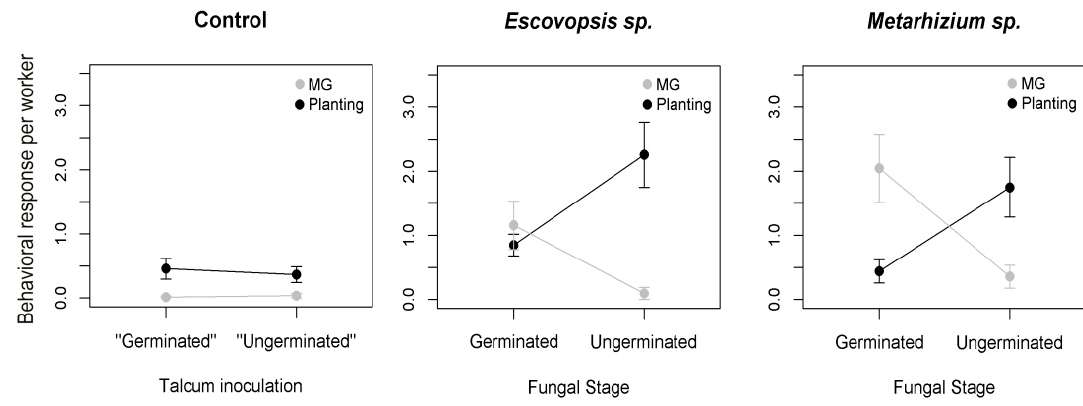
Figure 2. Mean ± standard errors frequencies of the hygienic behaviors metapleural gland (MG) grooming (MG: Grey dots) and fungal mutualist planting (black dots) exhibited by Trachymyrmex sp. 10 fungus-growing ants, in response to the germinated conidia or ungerminated conidia of the Escovopis and Metarhizium fungal parasites. Control treatments were talcum powder (for ungerminated conidia) or talcum powder contaminated by a fungal mutualist (for germinated conidia).